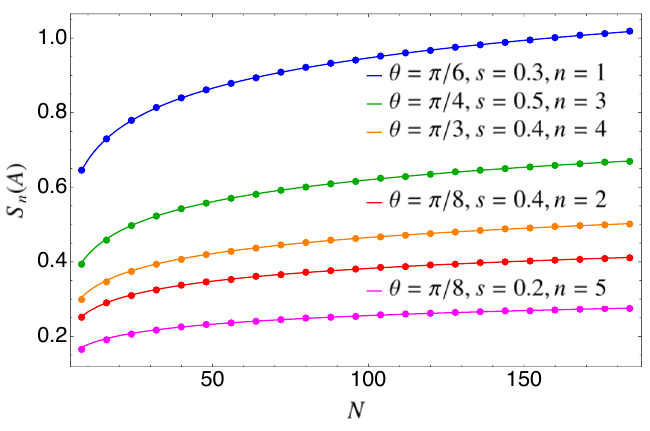
Figure 3 . The Rényi entropies S n ( A ) in a four-wire junction where A is made up of two wires. We choose different values of s, θ, n and we plot it as a function of the number of particles N . The lines show the curve C ( s, θ ) log N + b + b − 1 /n where the coefficients b n 0 1 N data for N ≥ 80 . The coefficients C ( s, θ ) are obtained by summing over the single-wire results, as n explained in eq.